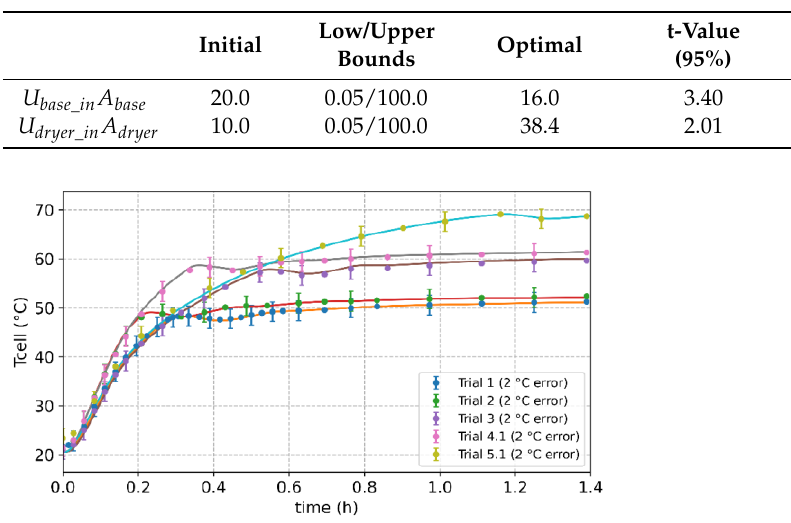
Figure 8. Comparison between experimental and predicted average cell temperatures.